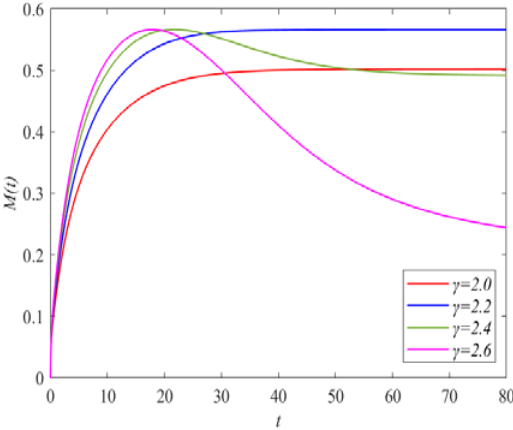
Fig. 6. Evolution of infected nodes with different power law index values.